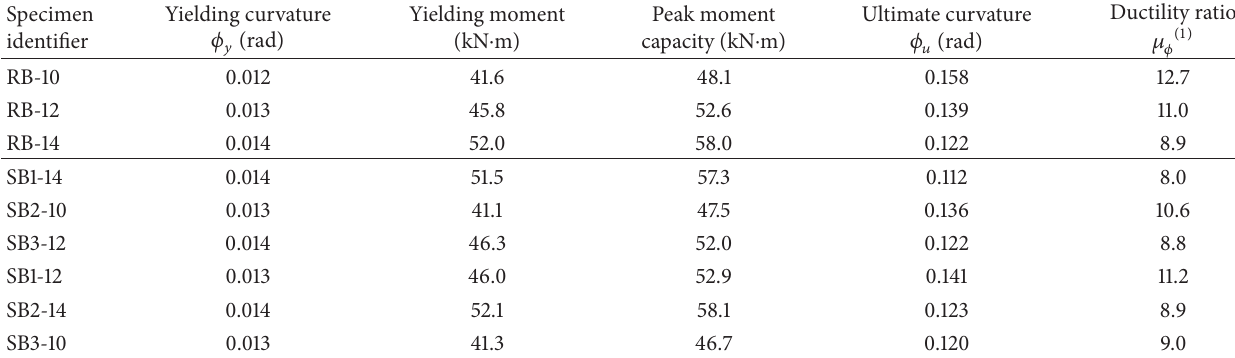
Table 5: Characteristic points on the calculated moment curvature curves of the specimens.